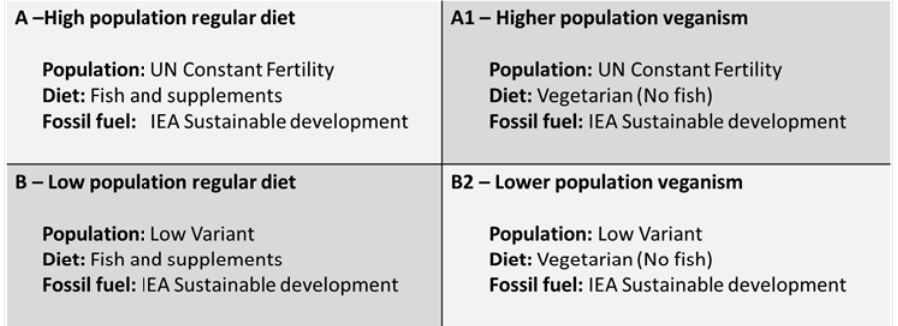
Figure 4. Analyzed frameworks for C. cohnii supply (higher-end needs).